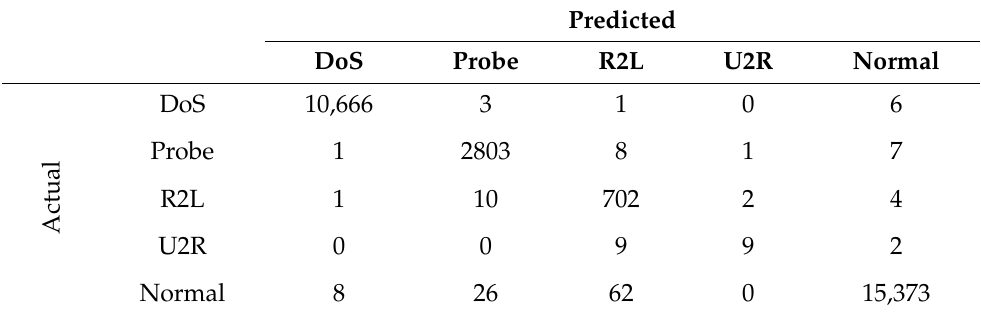
Table 12. Confusion matrix for NSL-KDD “reduced features” multiclass classification experiment.